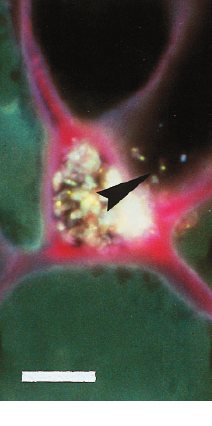
Fig. 12. Single bacte- ria inside the paren- chyma cell of a knot (arrow). Bar=10 μ m